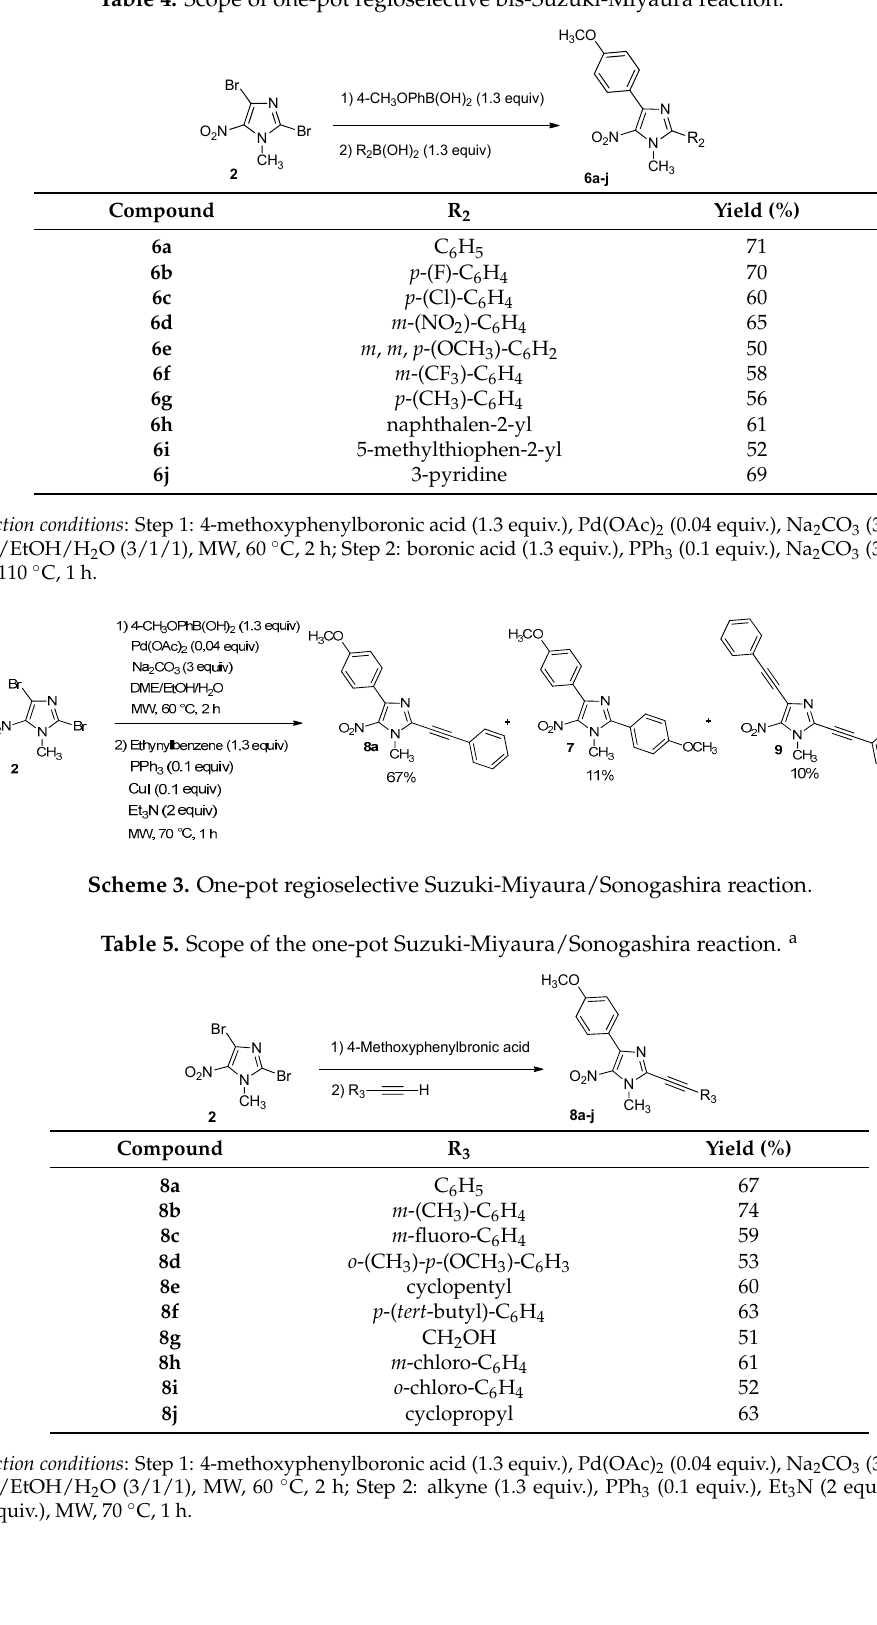
Table 4. Scope of one-pot regioselective bis-Suzuki-Miyaura reaction. a